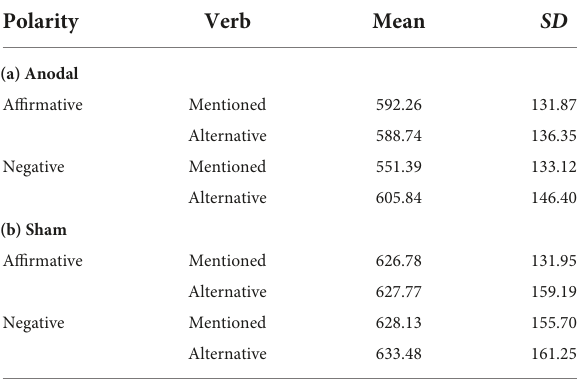
TABLE 6 Means and standard deviations of reading time (ms) of mentioned and alternative verbs in affirmative and negative sentences of each tDCS